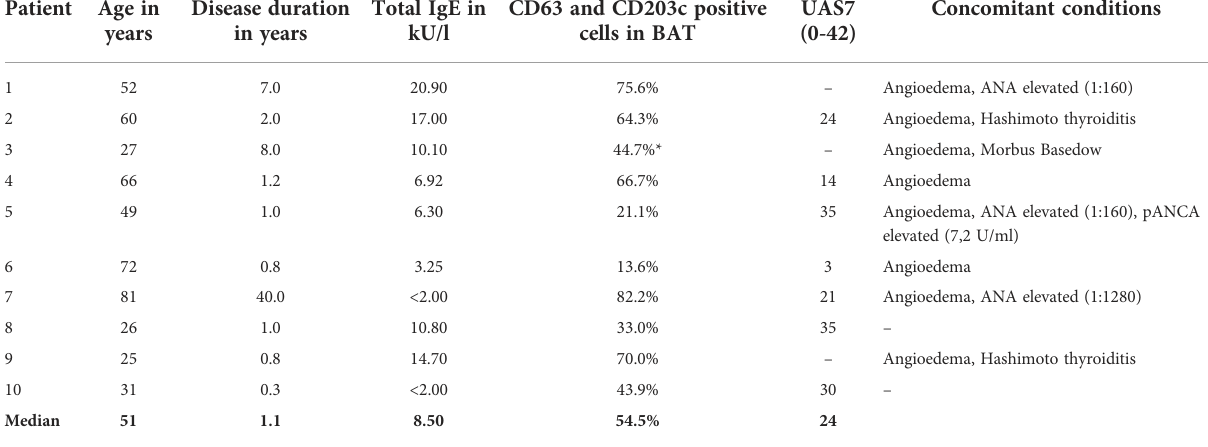
TABLE 2 Patient